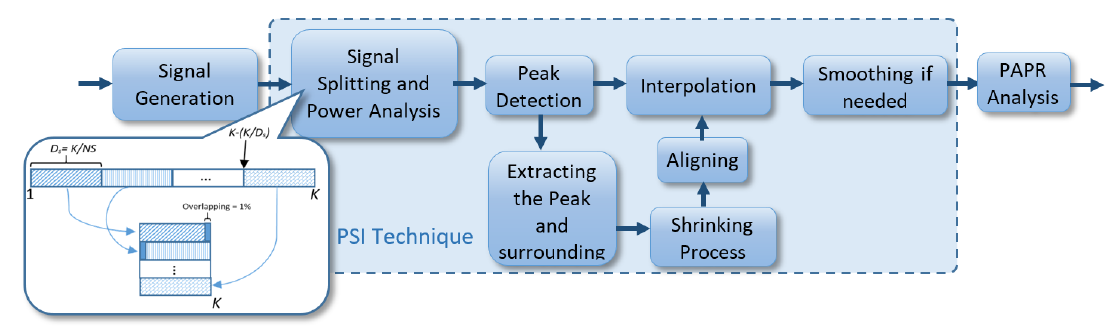
Figure 5. Block diagram of proposed PSI technique